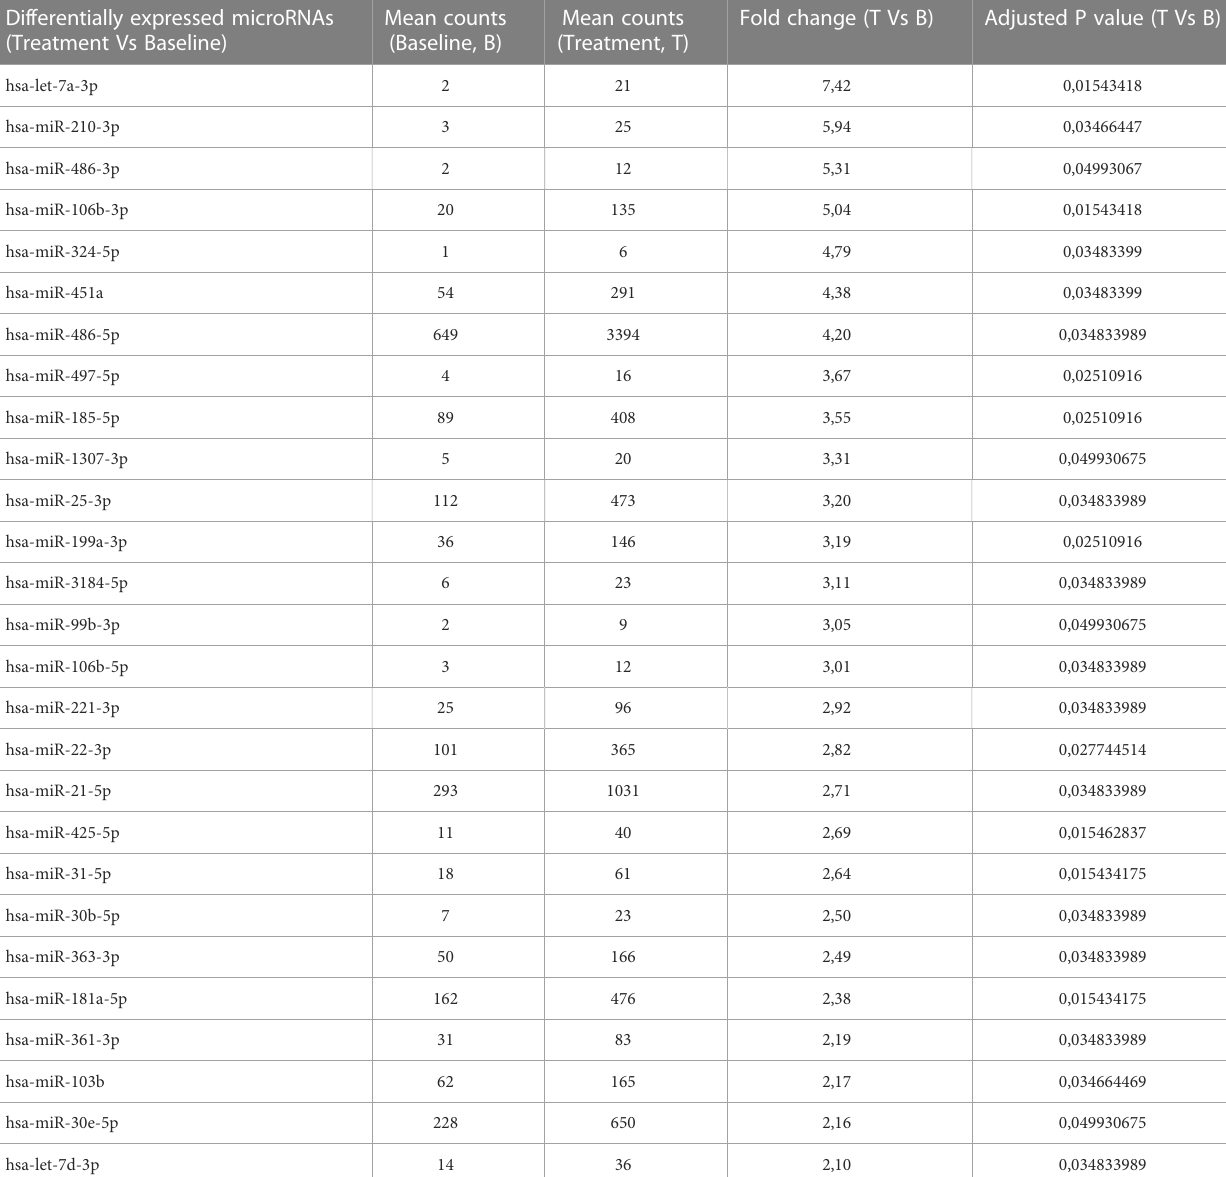
TABLE 1 27 upregulated differentially expressed microRNAs in women with adenomyosis after bromocriptine treatment compared to before bromocriptine treatment. Differentially expressed